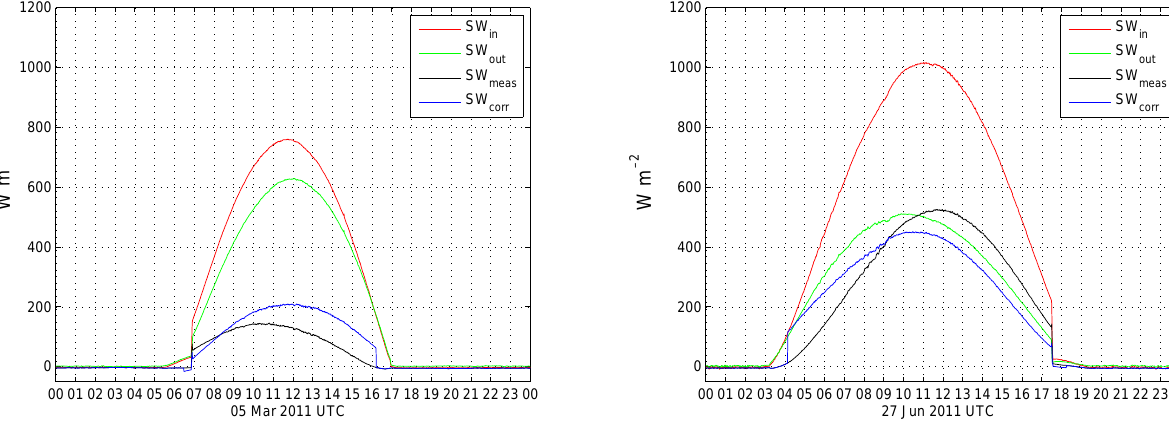
Figure 11. Measured (SW meas ) and corrected (SW corr ) net short-wave radiative balance on Kleinfleißkees on 5 March 2011 (left) and on Goldbergkees on 27 June 2011